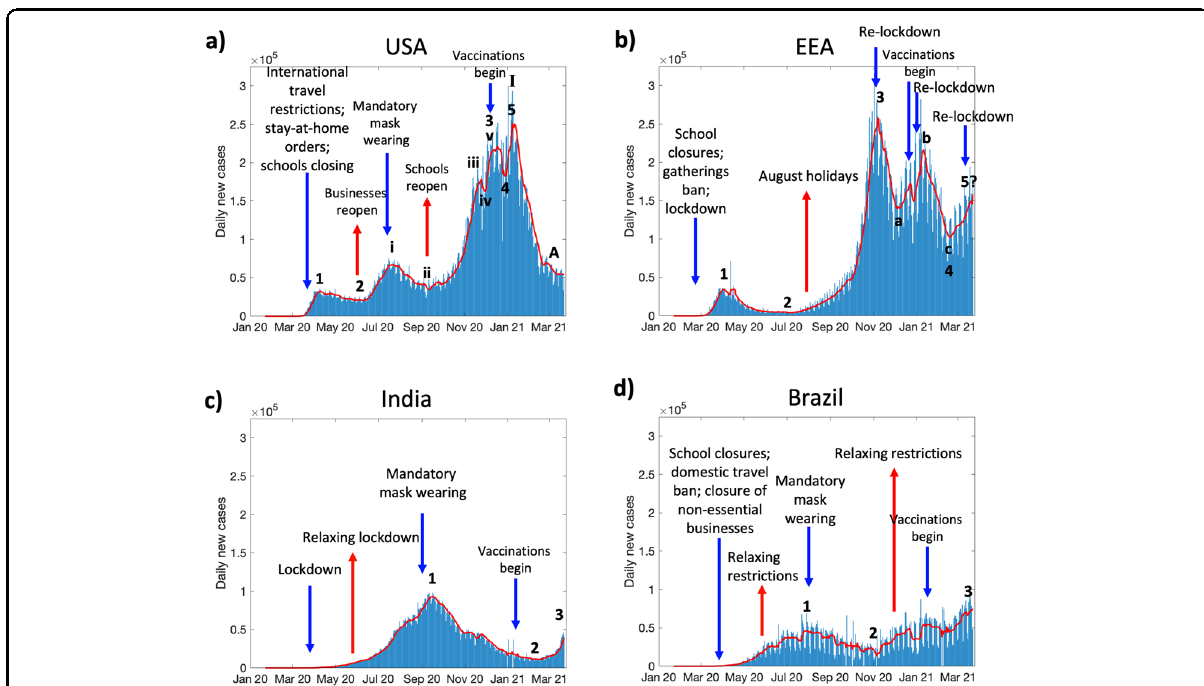
Fig. 2 Application of Wave Principle to COVID-19 pandemic. Daily new case timeline of COVID-19 in ( a ) USA, b European Economic Area (EEA), c India, and ( d ) Brazil, until 3/22/2021. Red line represents 7-day moving average of the cases. Impulses 1, 3, 5, (or, i, iii, v) and correctives 2 and 4 (or, ii and iv) are shown wherever they are visible. Blue and red arrows indicate the major restrictive and permissive events, respectively. Data source: